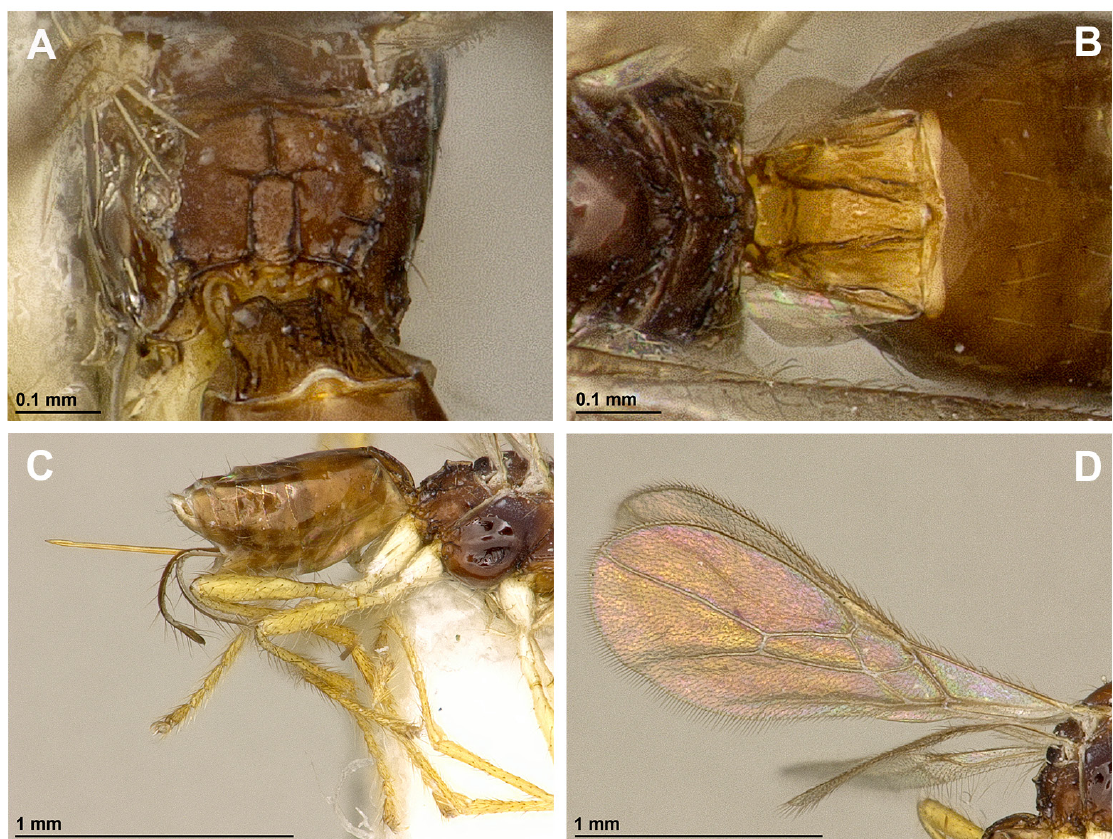
Fig. 36. Asobara laticlypeata van Achterberg, sp. nov., ♀, holotype (RMNH). A . Propodeum. B . First metasomal tergite, dorsal view. C . Hind leg, metasoma and ovipositor, lateral view. D . Fore and hind